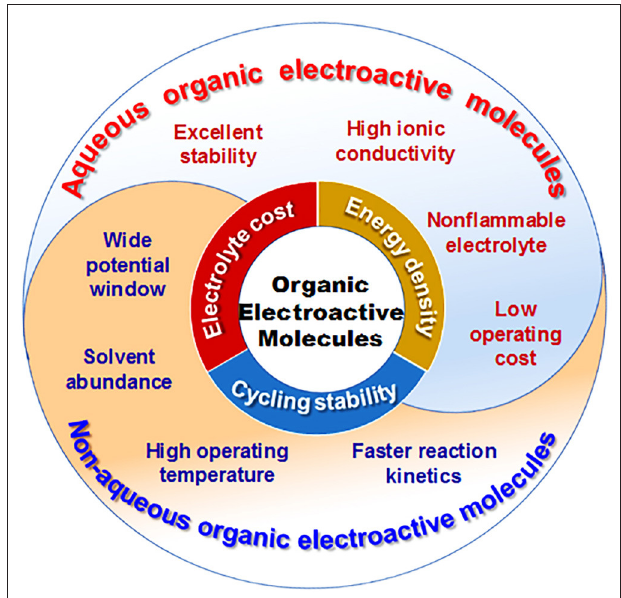
FIGURE 10 | Correlation diagram of features of organic electroactive molecules in aqueous and non-aqueous RFBs, respectively.